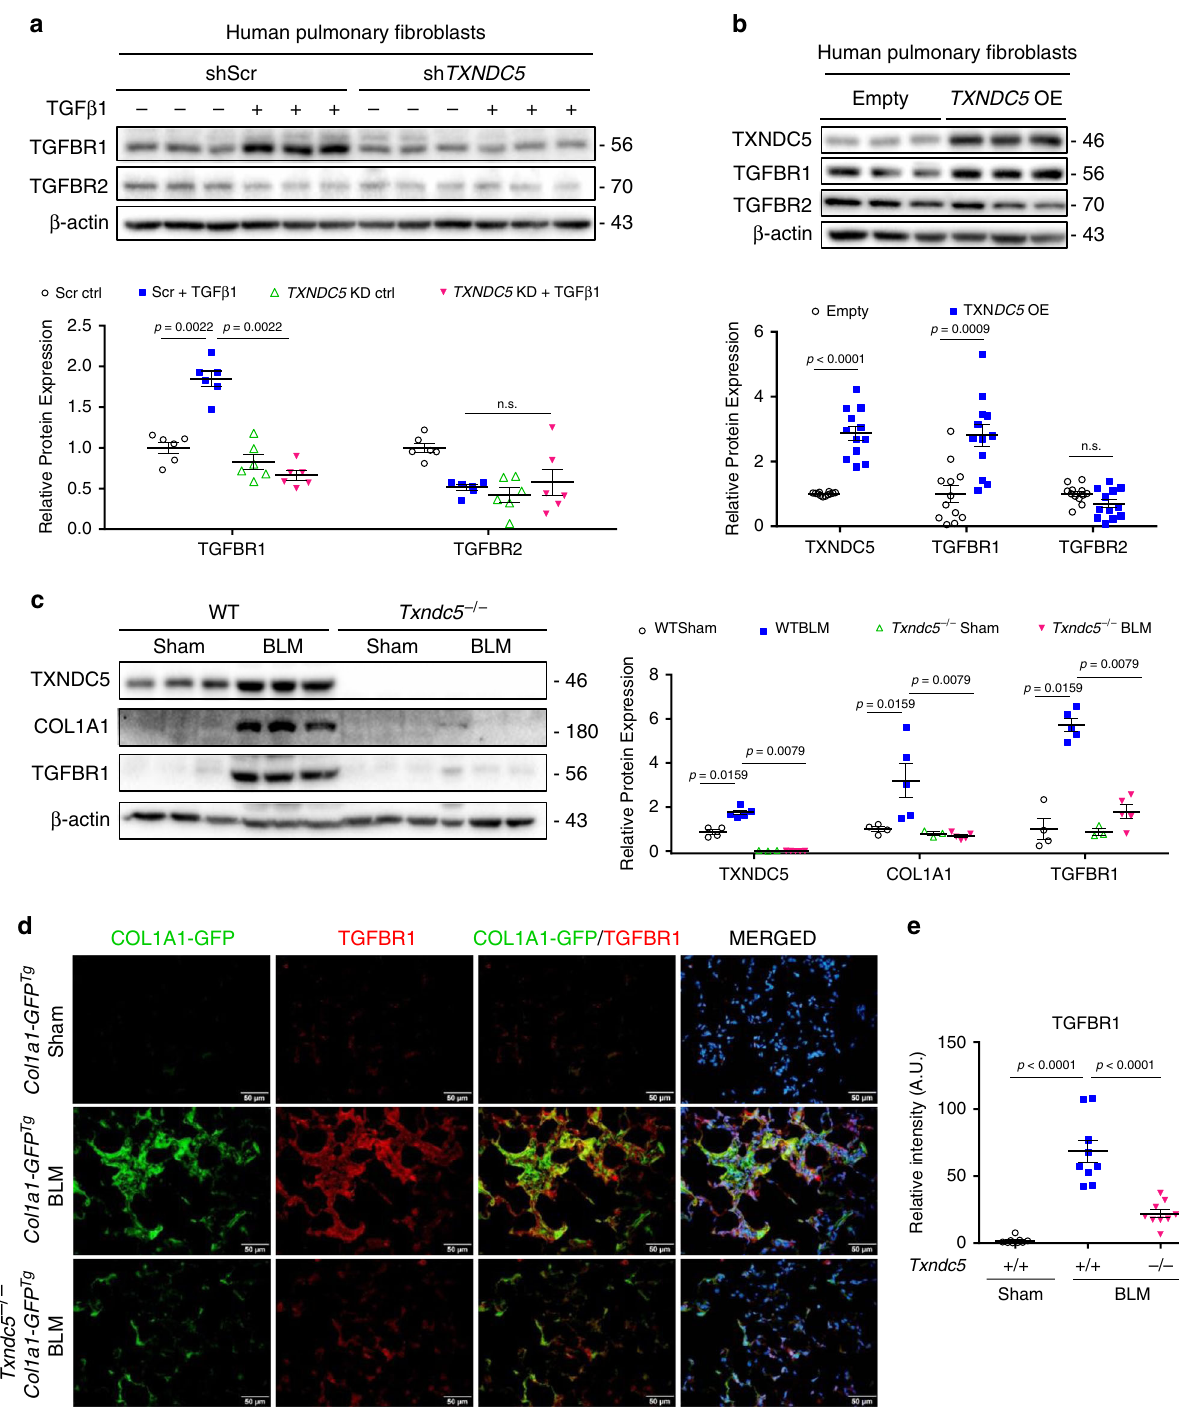
Fig. 6 TXNDC5 modulates TGFBR1 expression in human lung fi broblasts and mouse lungs. a Immunoblots showed that TGFBR1, but not TGFBR2, was markedly upregulated in control HPF (shScr) following TGF β 1 treatment. TXNDC5 knockdown (sh TXNDC5 ) prevented TGFBR1 upregulation induced